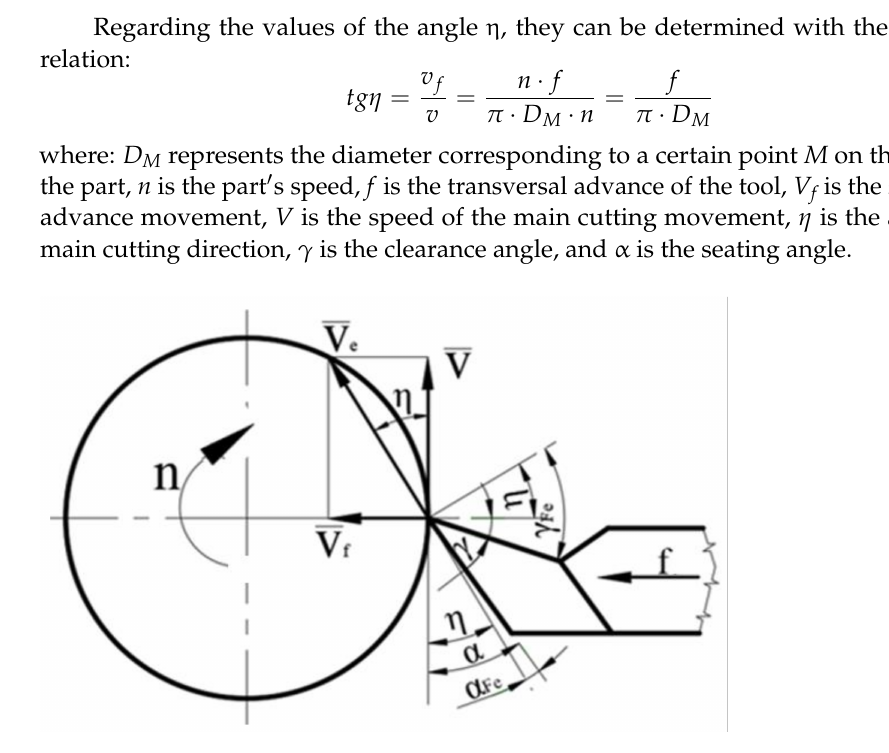
Figure 3. Kinematics of turning machining with transverse feed.